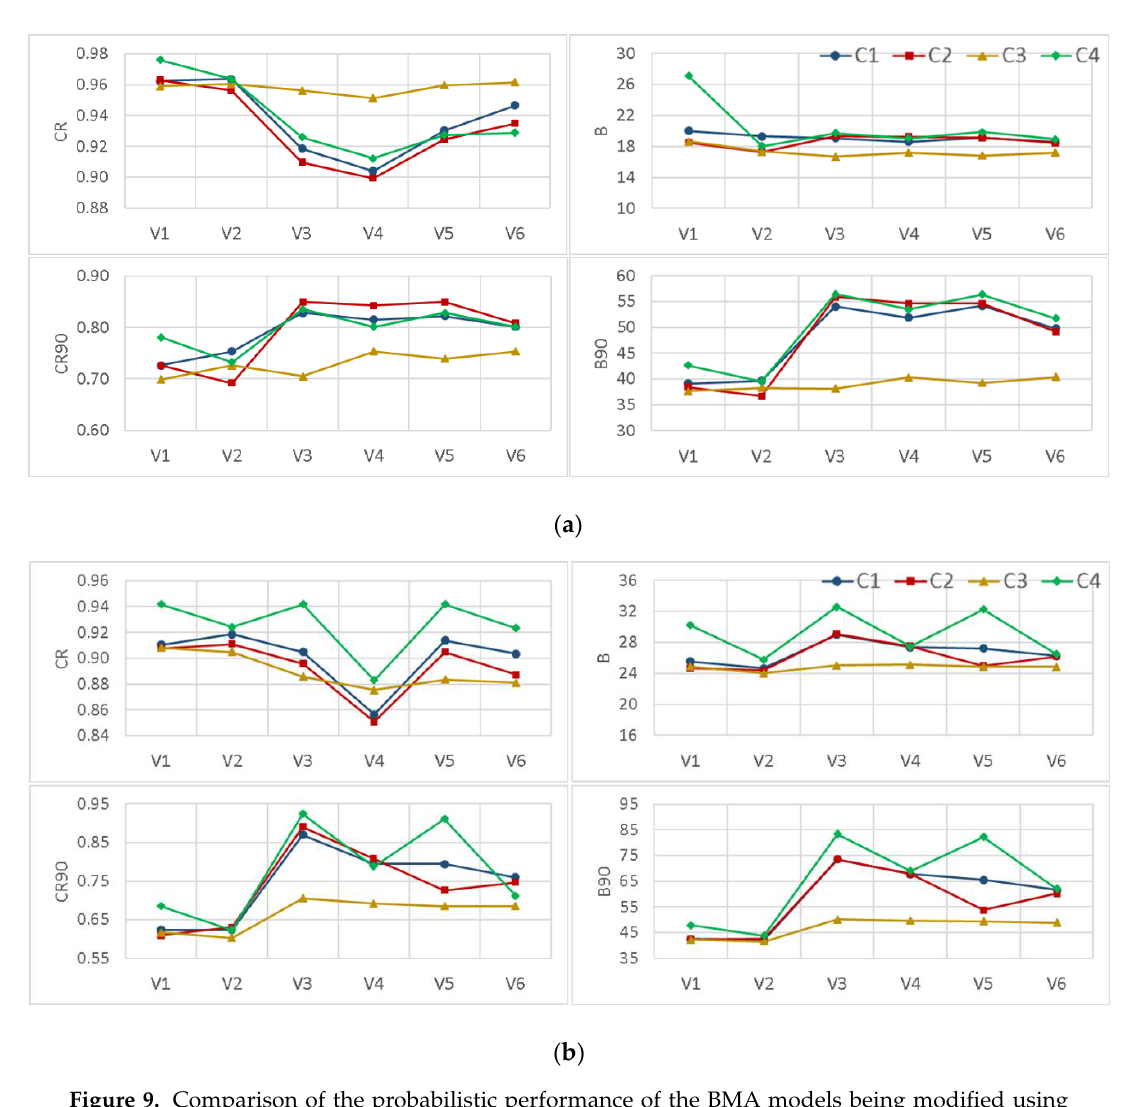
Figure 9. Comparison of the probabilistic performance of the BMA models being modified using different distribution and variance types for the validation period in the ( a ) Big East River and ( b ) Black River watersheds.